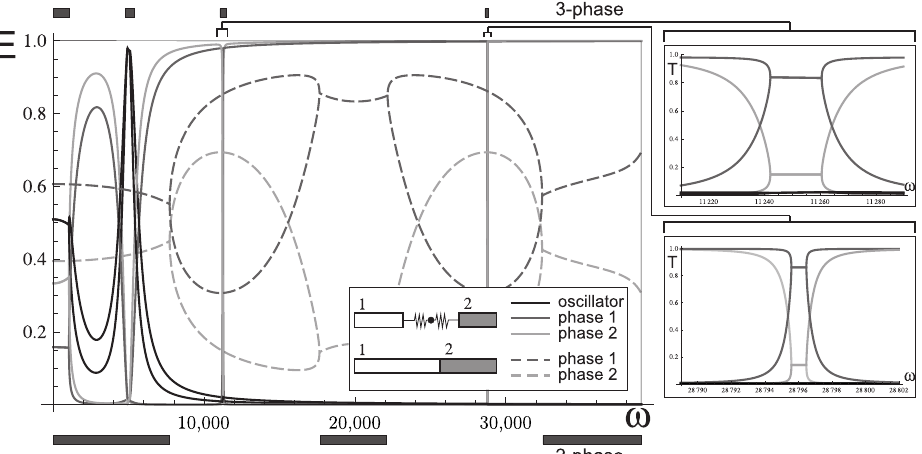
Figure 15. Energy distribution between different phases as a function of the radian frequency ω . Dashed lines correspond to the bi-layered system, while the continuous line corresponds to the bi-layered system with the oscillator disposed in series (indicated in black). Details of the second and third pass-bands are given on the right. Material and geometrical parameters are the same as Figures 6a and 11. Pass band frequency intervals are indicated at the top and at the bottom of the